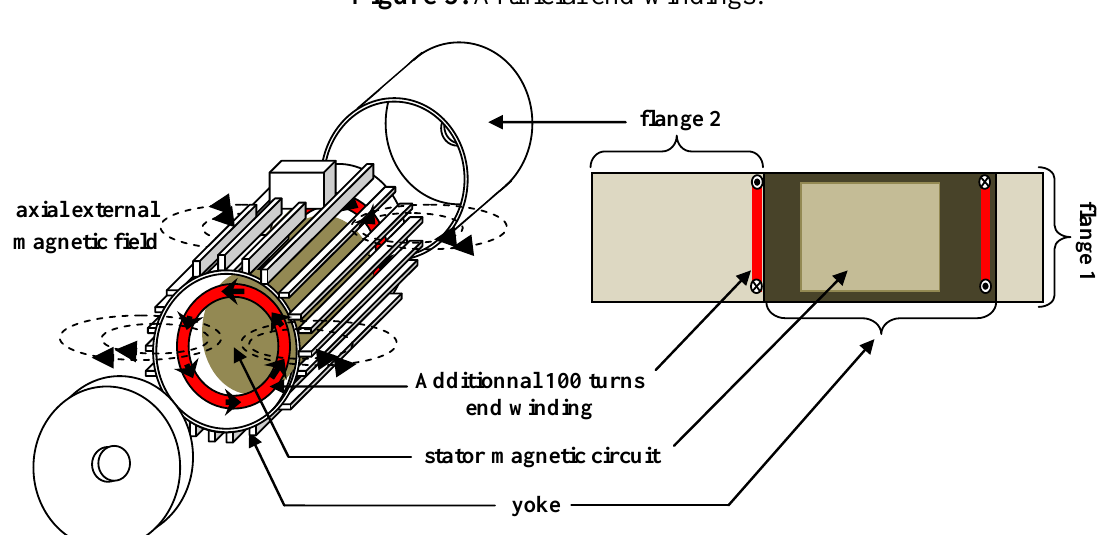
Figure 5. Artificial